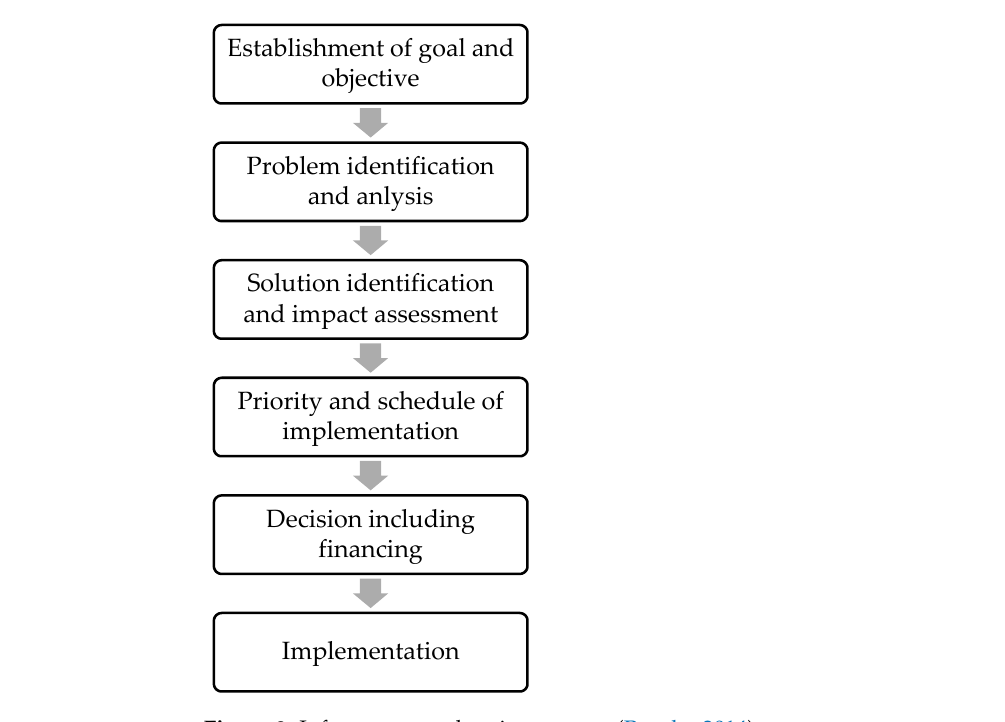
Figure 3. Infrastructure planning process (Pancho 2014).